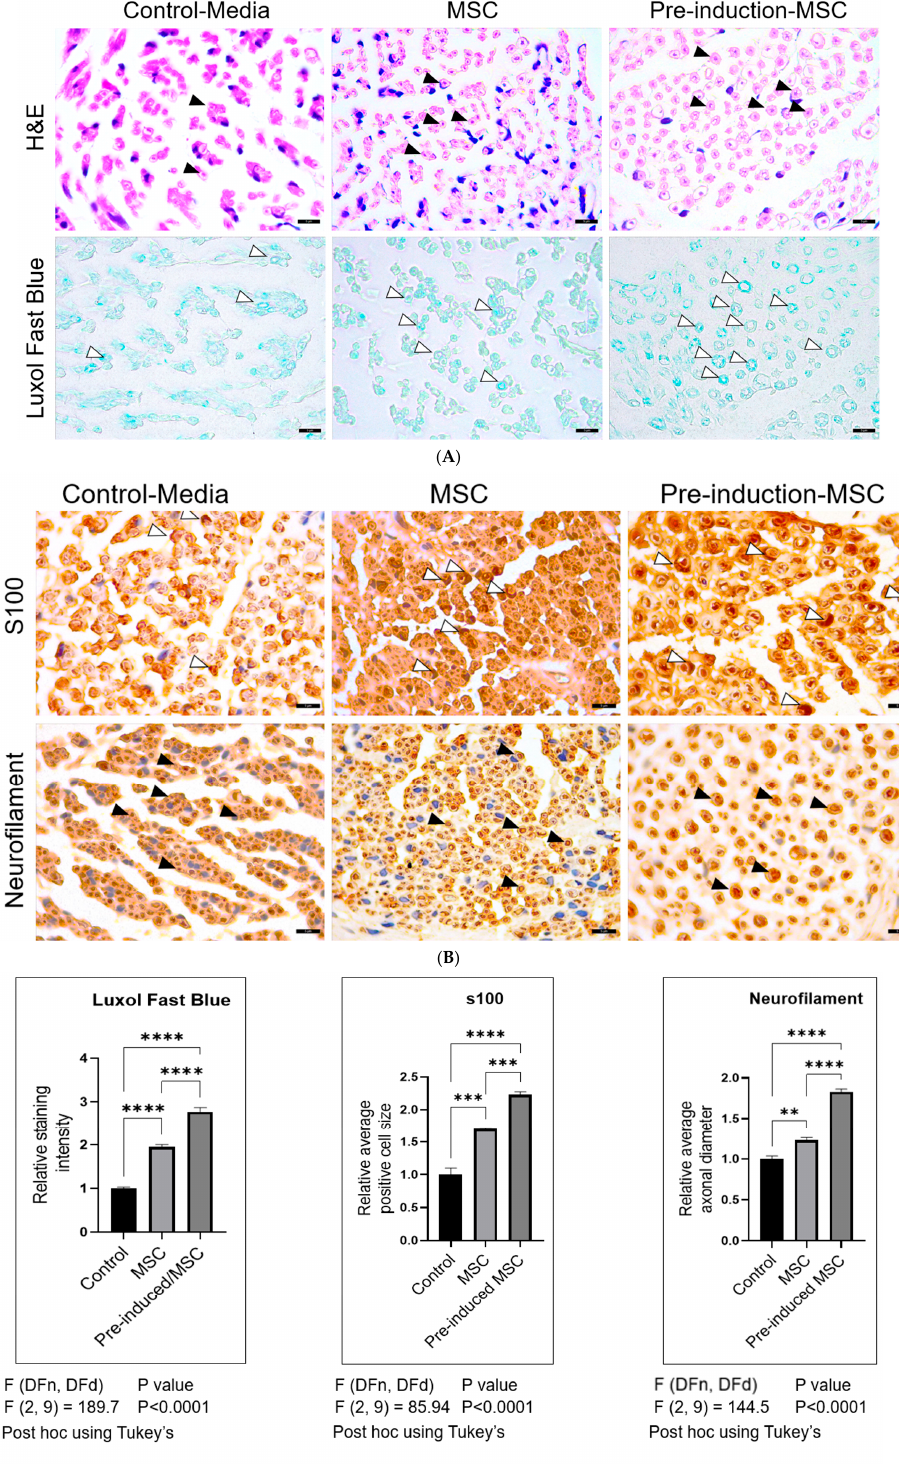
Figure 7. Pre-induced MSC showed better regeneration than other groups. ( A ) both groups I and II (treated with the MSC-coated nerve conduit) exhibited larger axons than the control group. ( B ) H&E and neurofilament immunostaining revealed smaller axonal diameters in the regenerated nerve fibers of the control group. ( C ) treatment with the MSC-coated nerve conduit alleviated this poor regeneration effect observed in the control group. Values of ** p < 0.01, *** p < 0.001, and **** p < 0.0001 were considered statistically